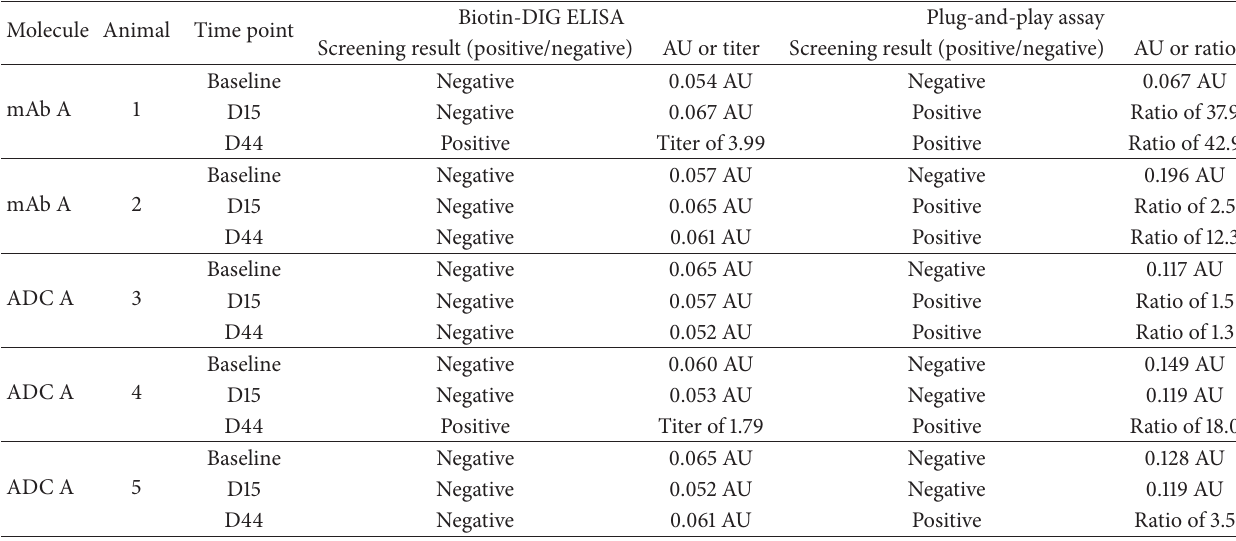
ADAs = anti-drug antibodies; ADC = antibody-drug conjugate; AU = absorbance units; D = days after dosing or after baseline; mAb = monoclonal antibody; R = ratio. Ratio = (postbaseline AU/baseline